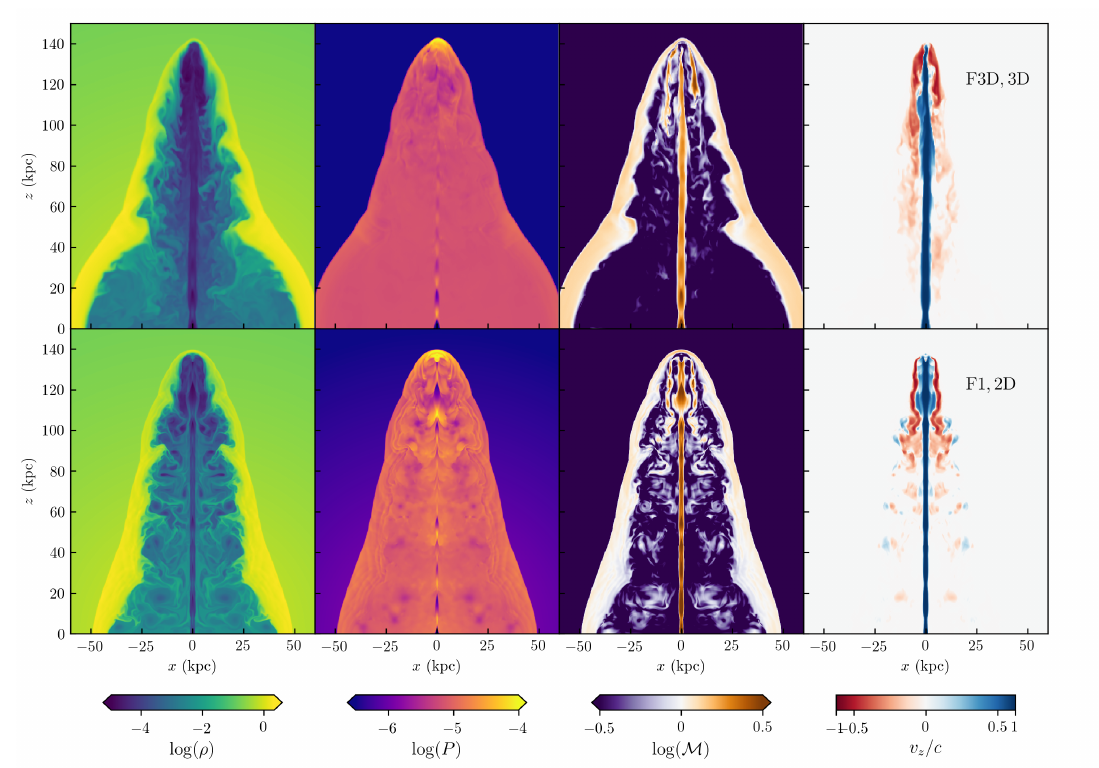
Figure 3: Four physical quantities (density, pressure, Mach number and vertical velocity) in the jet shown as a slice at y = 0 kpc, where the domain extends from − 60 kpc to 60 kpc in x and y (the 2D simulation has been reflected about the z axis). The jet is supersonic and produces a termination shock. The high-pressure post-shock material inflates a low-density cocoon and drives a bow shock into the surrounding material. As predicted by the Bernoulli analysis, fast backflows can form between the jet head and cocoon. These backflows are supersonic and produce